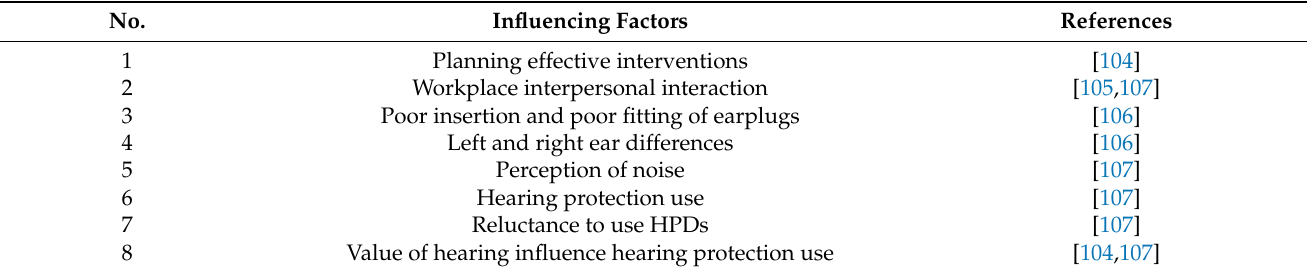
Table 10. Influencing factors of hearing protection